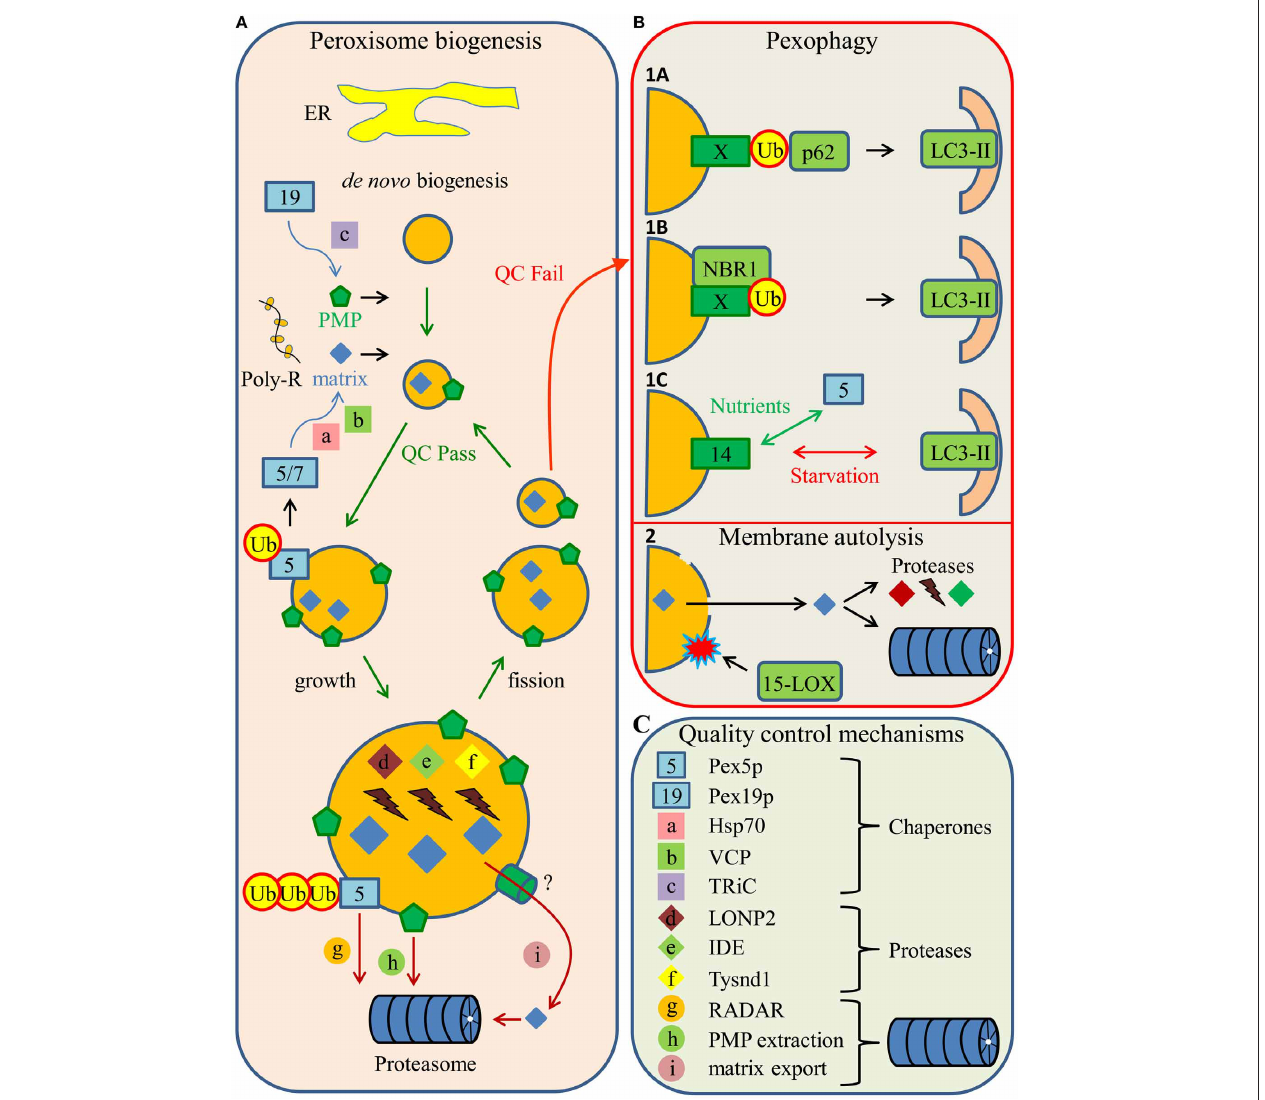
FIGURE 1 | Peroxisome biogenesis, quality control, and turnover in mammaliancells. (A) Peroxisomescan be formed de novo from the ER or by growth and asymmetric fission of pre-existing organelles. Peroxisomal matrix (matrix) and membrane (PMP) proteins are translated on free polyribosomes (Poly-R) in the cytosol, where they are recognized by their cognate import receptors Pex5p, Pex7p, or Pex19p (these and other peroxins are represented by numbers). Importantly, Pex5p and Pex19p possess chaperone-like activities. In addition, matrix protein folding is facilitated by the cytosolic chaperones Hsp70 and VCP, whereas PMP folding is assisted by the chaperonin TRiC (all non-peroxin-related quality control mechanisms are indicated by lower-case letters and listed in panel C ). At the peroxisomal membrane, Pex5p is either mono- or poly-ubiquitinated (Ub). In the case of mono-ubiquitination, Pex5p is extracted from the membrane into the cytosol for a new round of matrix protein import. However, upon poly-ubiquitination, Pex5p is degraded by the proteasome in a process known as RADAR. Superfluousor dysfunctional PMPs are also targets for proteasomal degradation. The peroxisomal matrix harbors several proteases (e.g., LONP2, IDE, and Tysnd1) that function as regulators of intra-peroxisomal proteostasis. In addition, excessive peroxisomal matrix proteins may be exported to the cytosol where they are degraded by cytosolic proteases or the proteasome.